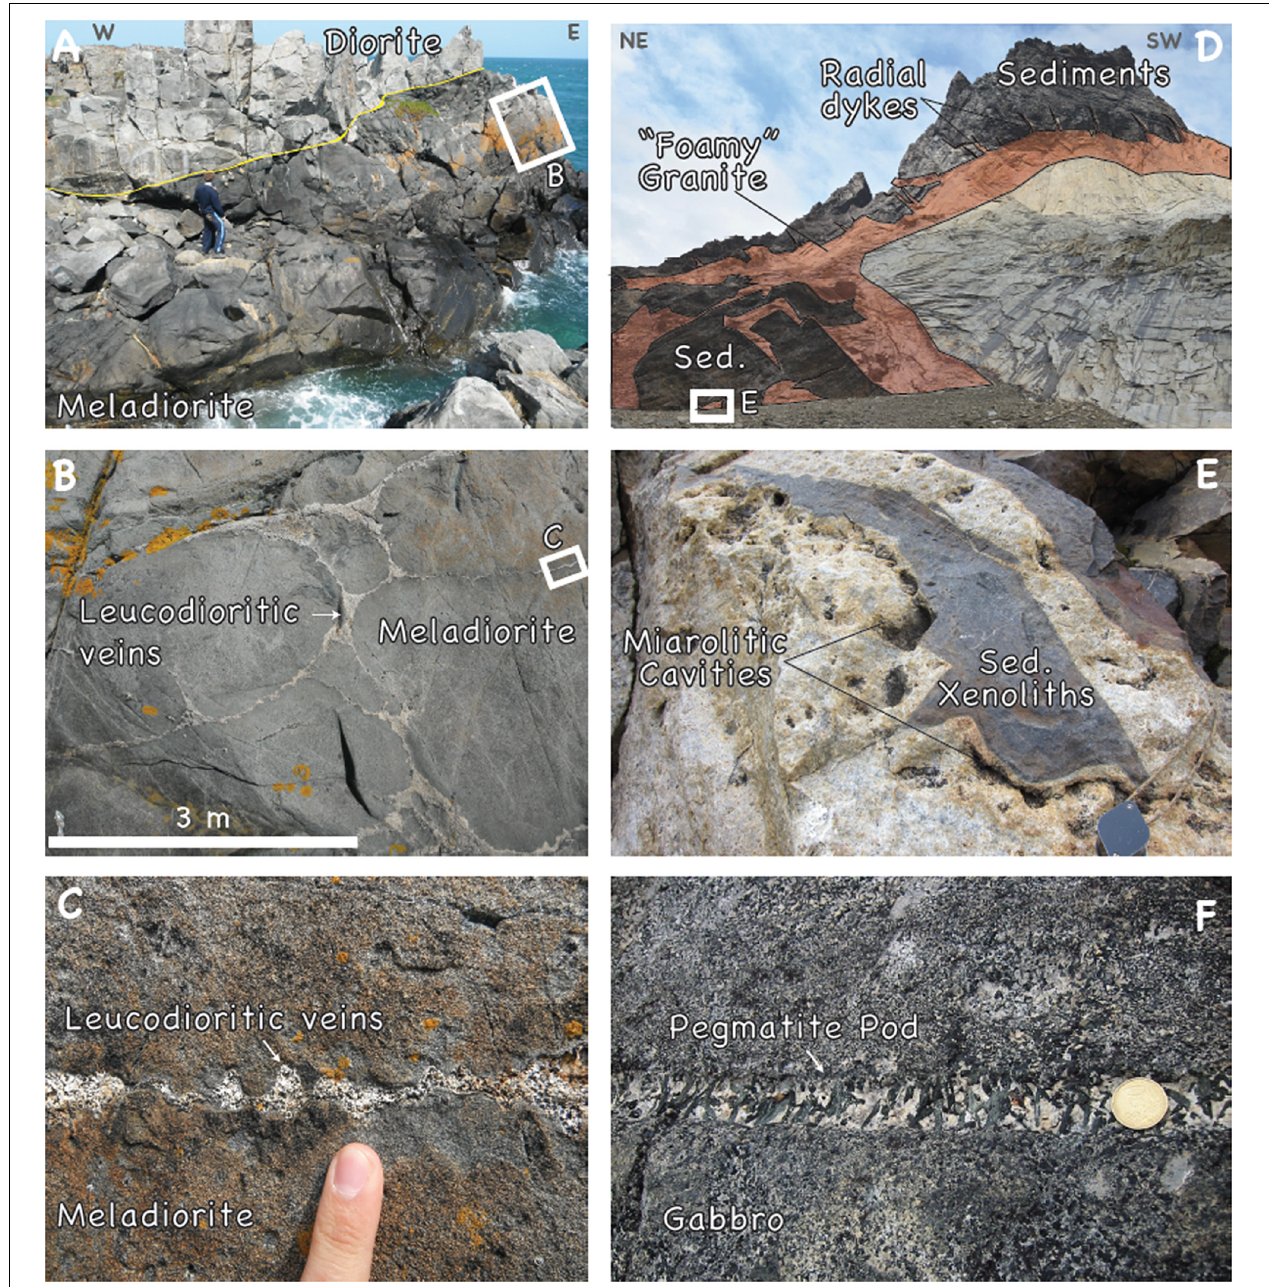
FIGURE 1 | Examples of melt and gas segregation within cooling magmas. (A–C) Outcrops of the Beaucette Marina battery of the gabbro-dioritic Bordeaux Group (North-Guernsey Intrusive Complex, Armorican Massif; Caroff et al., 2011) show a cumulative macrorhythmic sequence of meladiorite and diorite rocks. The meladiorite unit consists of alternating dark and few cm-thick mesocratic layers and is veined by leucocratic diorite with vuggy porosity, forming an inter- and cross-connected network of cm-thick sheets. (D) Image of the ca. 900 m high N-W cliff of the Cerro Nido el Condor (Patagonia, Chile) showing outcrop of the frontal part of the Torres del Paine igneous complex. The “foamy” granite from Unit I (Michel et al., 2008) is accumulated at the front and is enriched in miarolitic cavities. Note ubiquitous radial diking, and brecciation at the bottom of the laccolith. (E) Close-up on one of the dikes from the bottom of the Unit I, where both sedimentary xenoliths and magma solidification act as a barrier to gas and melt movements following dike emplacement. (F) Coarse pegmatite pods with hornblende and feldspar minerals arranged in a comb layer (a variant of unidirectional solidification texture or UST) with respect to the equigranular host gabbro from the Val Fredda Complex (Blundy and Sparks, 1992) of the Tertiary Adamello Batholith (Alps, Italy).